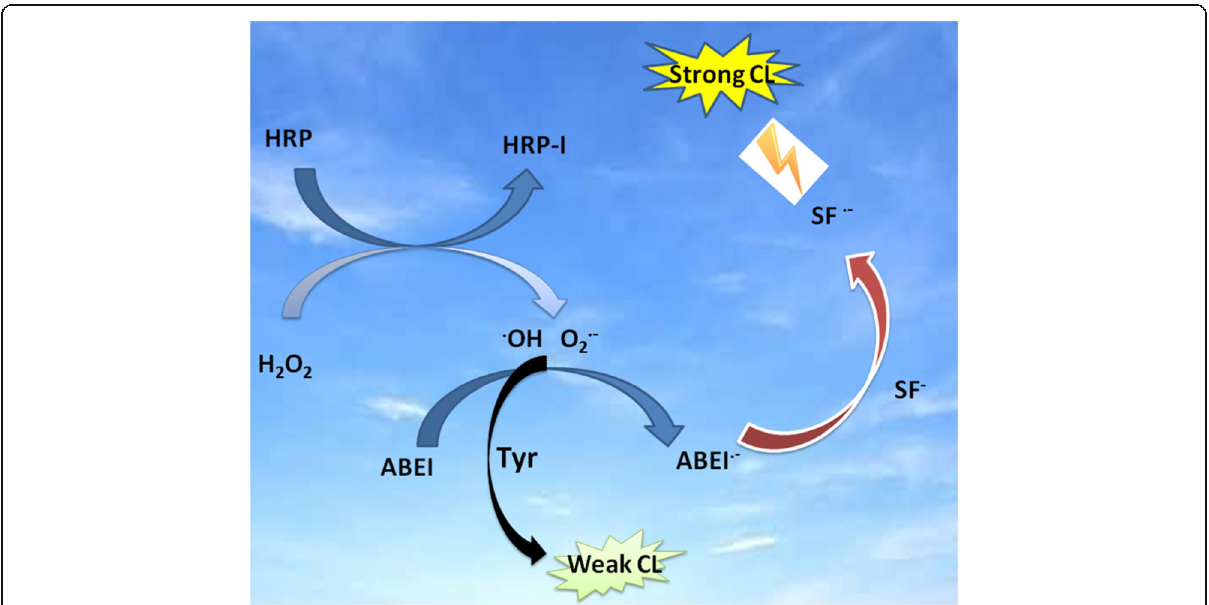
Fig. 3 The reaction process of the whole system